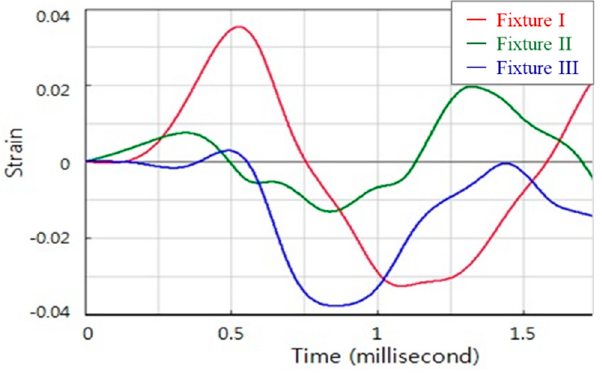
Figure 17. Time response of the tensile strain for all fixtures.